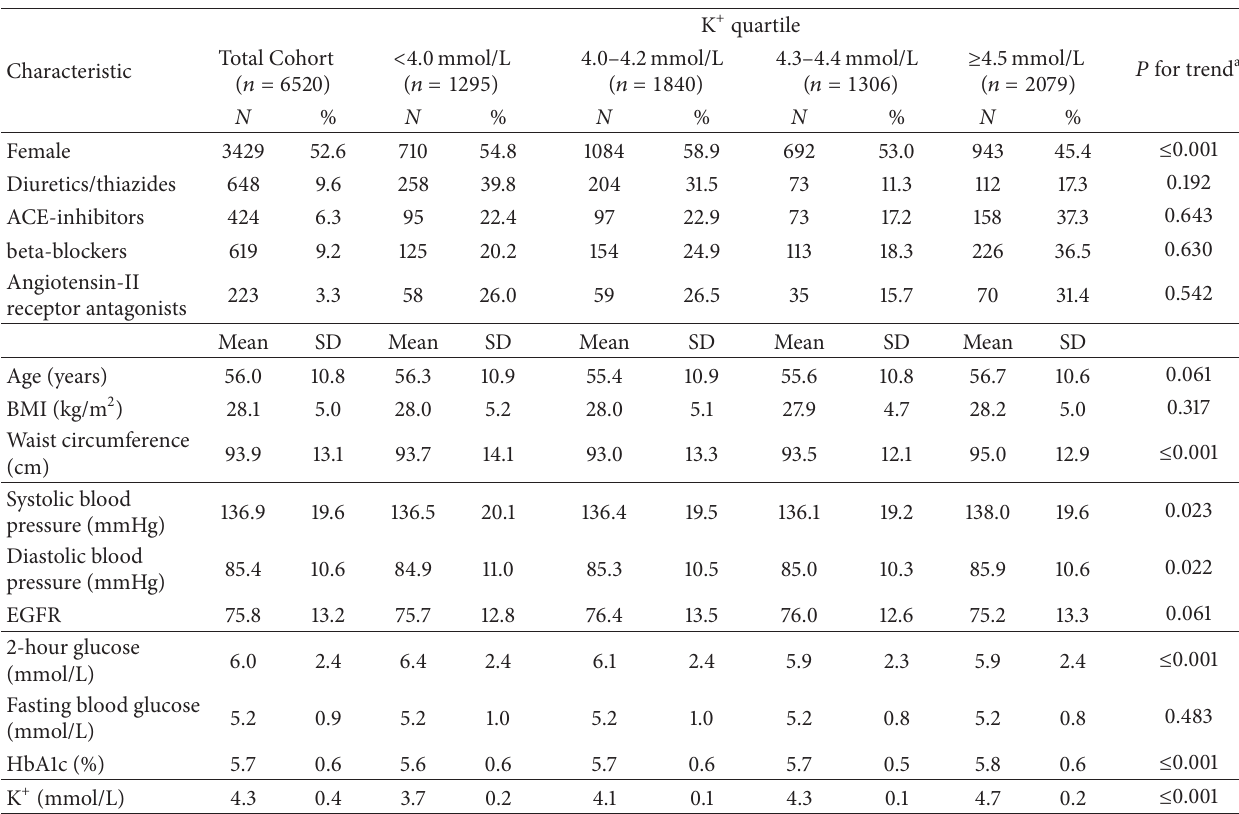
Table 1: Characteristics of 6520 participants in the ADDITION-Leicester cross-sectional screening study stratified by baseline serum potassium level.